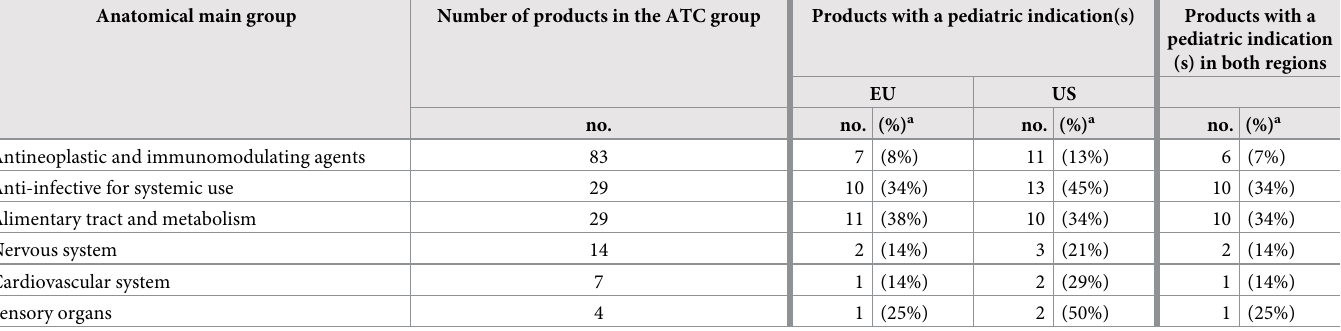
Table 2. Descriptive overview of therapeutic areas of products where differences exist in the pediatric indications approved in the EU and the US. Ordered after the therapeutic area for which most of the total active products were approved. See the S1 Table for an overview of the therapeutic areas of all products. Anatomical main group